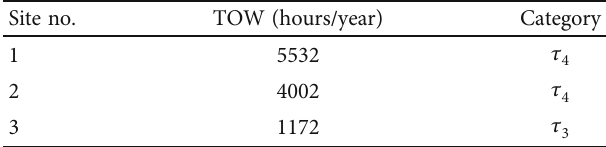
Table 3: Data of time of